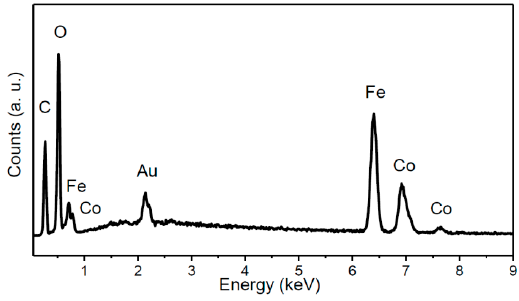
Figure 3. EDS spectrum of Co-Fe-GLY.